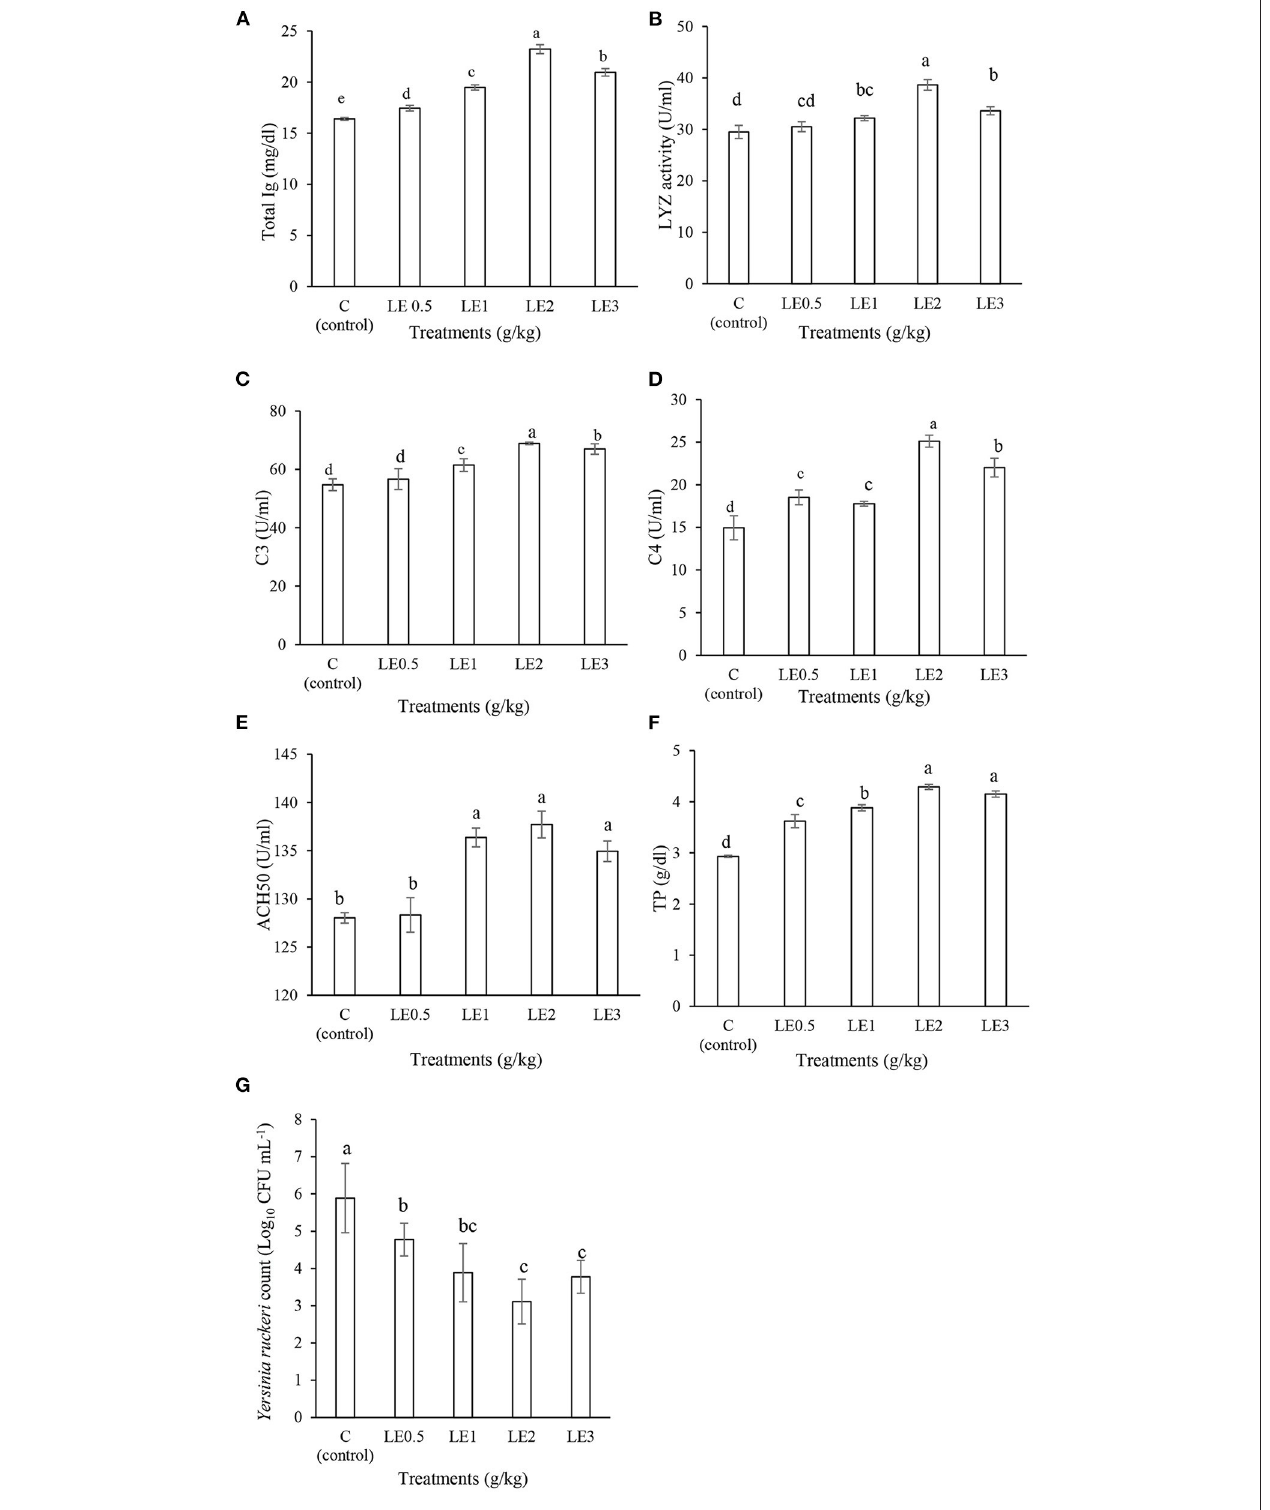
FIGURE 1 | Evaluation of the serum immunological values of total immunoglobulin (Ig) (A) , lysozyme activity (LYZ) (B) , complement component 3 (C3) (C) , complement component 4 (C4) (D) , complement pathway hemolytic activity (ACH50) (E) , total protein (TP) (F) , and serum bacterial count (G) in rainbow trout fed with different levels of licorice extract (LE) supplemented diets. Bars assigned with the same superscripts are not significantly different ( P > 0.05). Values are presented as the mean ± SD ( n = 3).